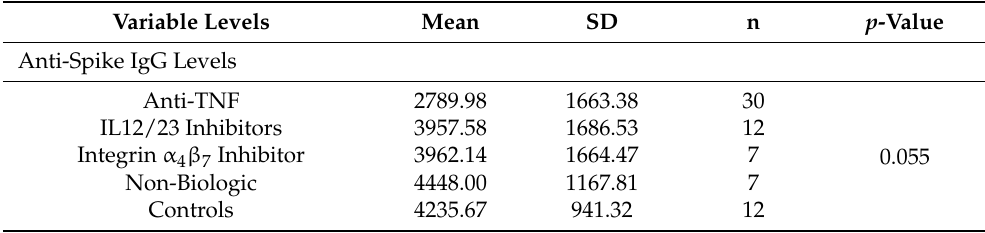
Table 2. Kruskal–Wallis Rank Sum Test for anti-Spike IgG levels and sVNT% stratified by therapy vs. control, and Pairwise Comparisons for the Mean